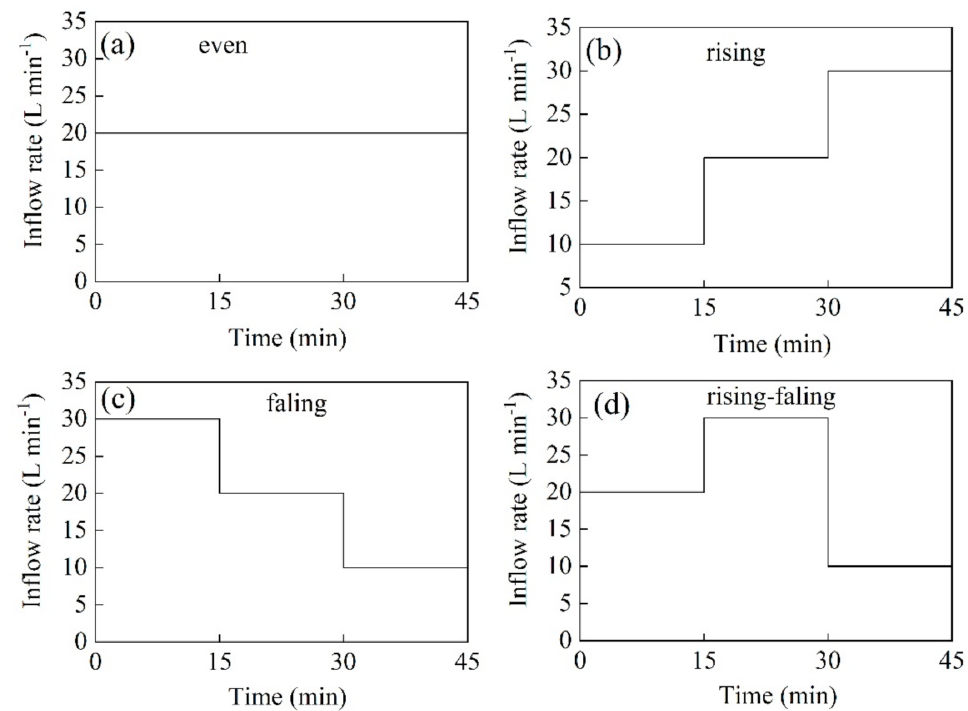
Figure 3. Inflow rate patterns designed for the experimental runoff plot: ( a ) even; ( b ) rising; ( c ) faling; ( d )